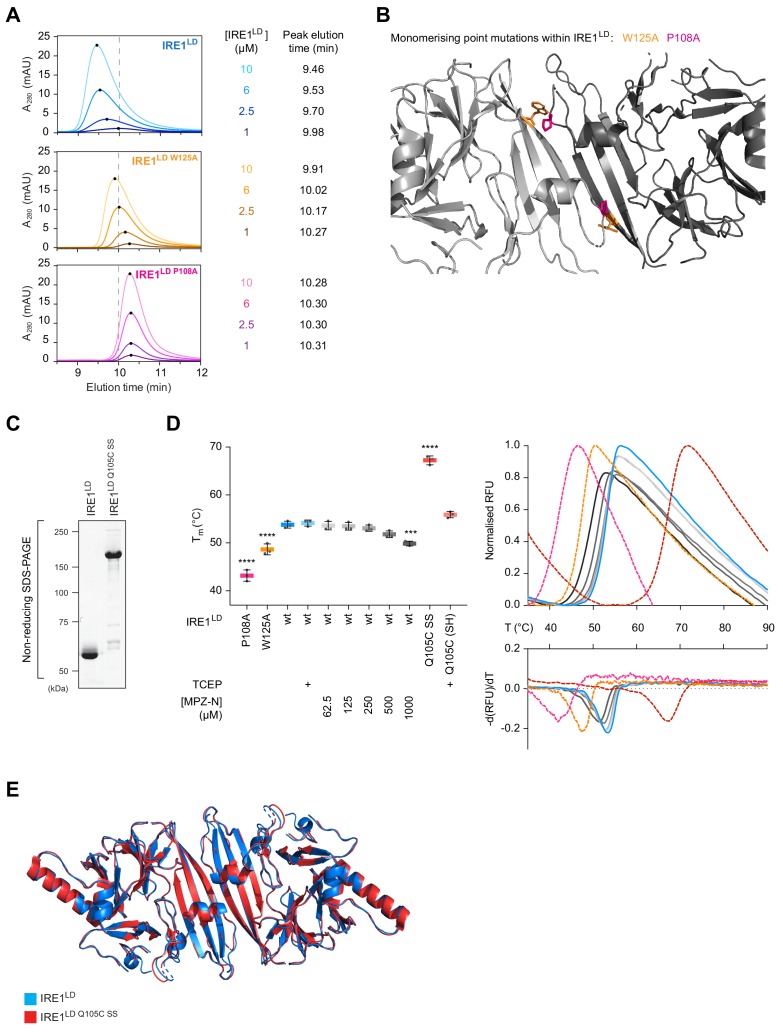
Biochemical properties of disulphide-linked dimeric IRE1LD Q105C SS and monomeric variants used to study MPZ-N’s interaction with IRE1LD.(A) Size-exclusion chromatography (SEC) elution profiles of wild-type (wt) and monomeric IRE1LD W125A and IRE1LD P108A proteins at the indicated concentrations. Protein absorbance at 280 nm (A280) is plotted against elution time. Note the delayed peak elution times of the IRE1LD monomeric variants. The observation that IRE1LD wt and IRE1LD W125A variants eluted in a single peak yet shifting to later elution times with decreasing protein concentrations suggests that these proteins existed in a monomer-dimer exchange regime that is faster than the time scale of SEC. By contrast, IRE1LD P108A was monomeric at all tested concentrations. (B) Cartoon representation of the IRE1LD dimer interface with protomers in light and dark grey (PDB: 2HZ6). Residues that were mutated to create the monomeric variants IRE1LD W125A and IRE1LD P108A are located in close proximity to the dimer interface and are shown in orange or pink sticks, respectively. (C) Coomassie stained non-reducing SDS-PAGE gel of wt IRE1LD and disulphide-linked IRE1LD Q105C SS. (D) Scatter plot of the melting temperature (Tm) of the indicated IRE1LD proteins (at 5 µM) in absence or presence of the reducing agent TCEP or increasing concentrations of MPZ-N peptide measured by differential scanning fluorimetry (DSF) is depicted on the left. Shown are the data points of three independent experiments [mean ± standard deviation (SD)] with monomeric IRE1LD W125A and IRE1LD P108A, wt IRE1LD and a disulphide-linked dimeric IRE1LD Q105C SS or its reduced version IRE1LD Q105C SH. Statistical analysis for indicated conditions was performed in comparison to wt IRE1LD (***: p<0.001, ****: p<0.0001, ordinary one-way ANOVA). Traces of melt curves with their negative first derivatives from a representative experiment are shown on the right (peak fluorescence was normalised). (E) Overlay of the cartoon representation of IRE1LD (PDB: 2HZ6) and the disulphide-linked IRE1LD Q105C SS. The root-mean squared deviation (RMSD) over 227 Cα atoms is 0.46 Å.Figure 2—figure supplement 1—source data 1.Source data for Figure 2—figure supplement 1A.Figure 2—figure supplement 1—source data 2.Source data for Figure 2—figure supplement 1D.